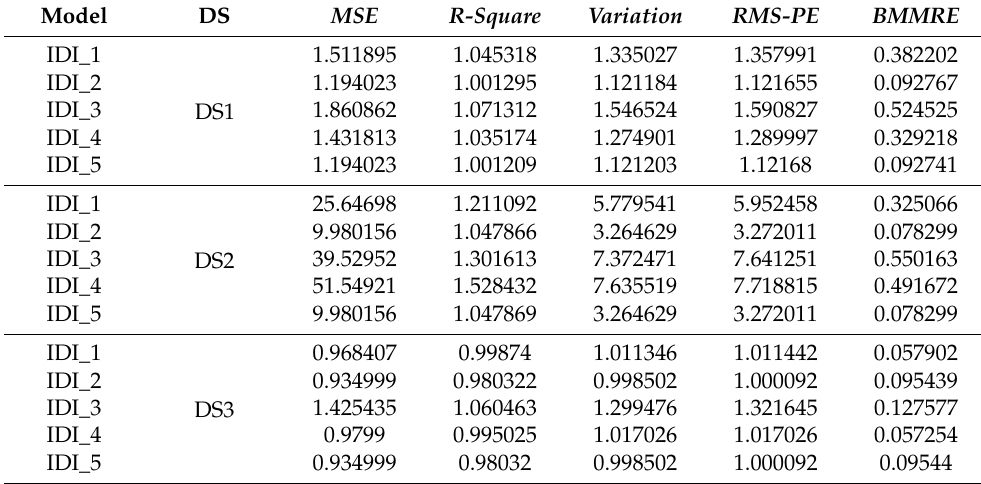
Table 2. Performance indicators of IDI-type